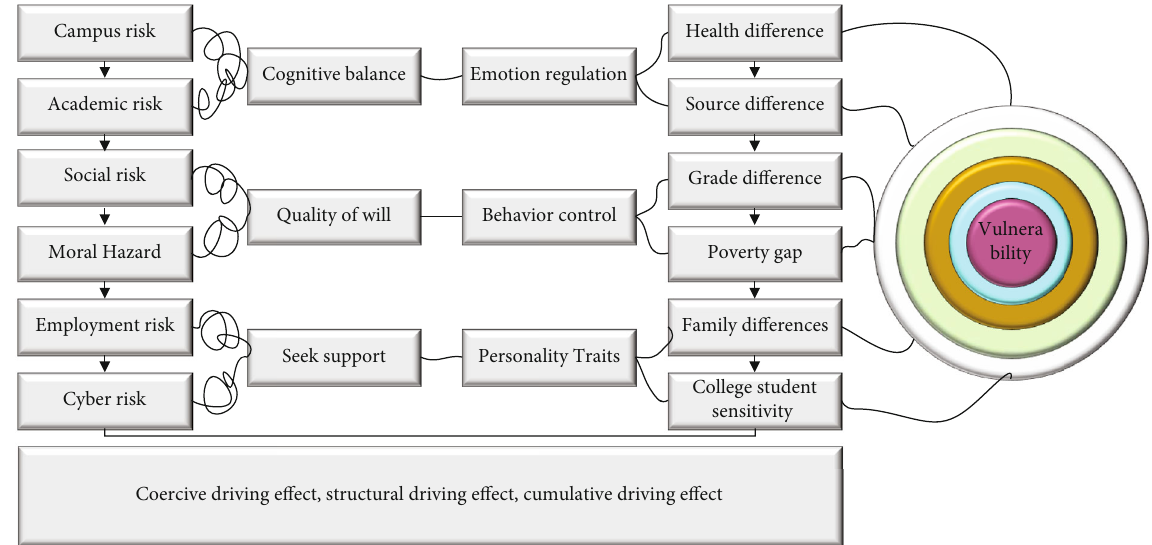
Figure 3: Model diagram of